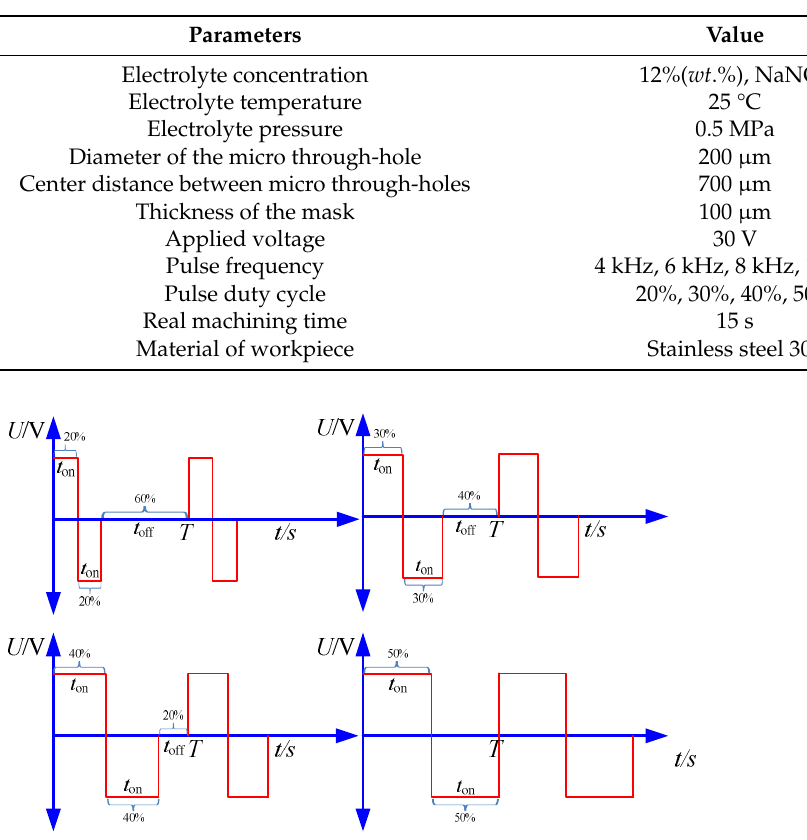
Figure 7. The mask used in the experiment.